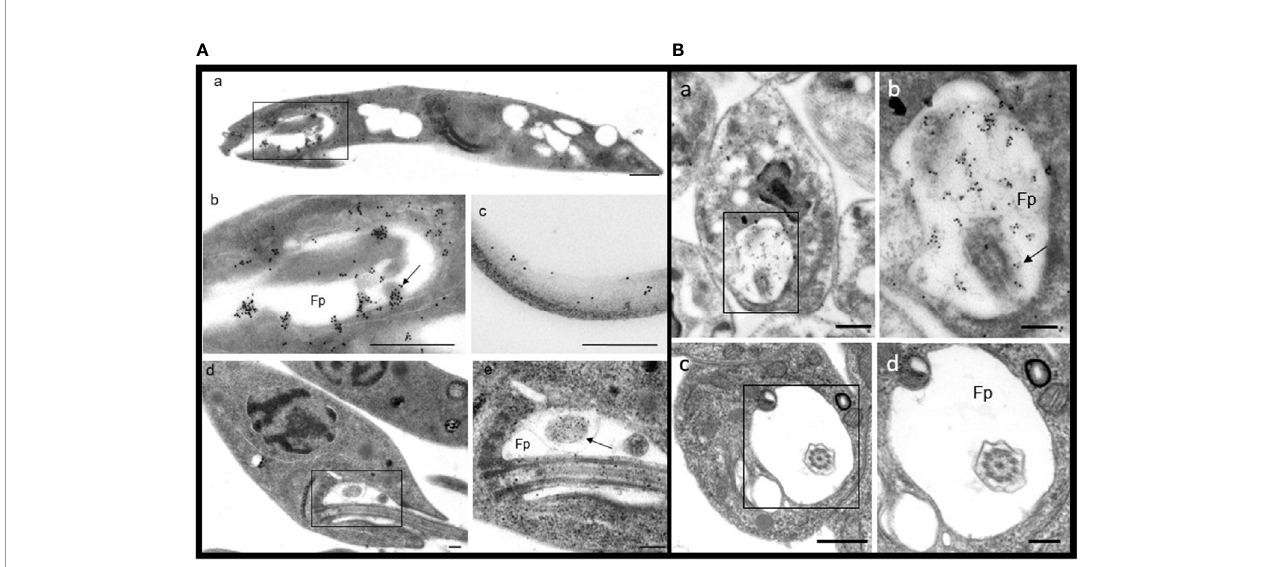
FIGURE 6 | Distribution of PP2C in promastigotes and amastigotes of L. mexicana . (A) Immune electron microscopy of LmxPP2C in promastigotes. The micrographs in A are of low (Images a and d) and high magni fi cation (images b, c and e) of promastigotes. Image (b) corresponds to a magni fi cation of the inset in (a). Micrographs (d) and (e) correspond to the control for the ultrastructure of a promastigote. The image (e) represents a magni fi cation of the inset in (a). Scale bars = 500 nm. (B) Immune electron microscopy of LmxPP2C in amastigotes. The micrographs are of low (images a and c) and high magni fi cation (b and d) of amastigotes. Image (b) portrays a magni fi cation of the inset in (a). Images (c) and (d) correspond to the control for ultrastructure of an amastigote. Fp, fl agellar pocket. Scale bars in a and c = 500 nm; scale bars in b and d = 200